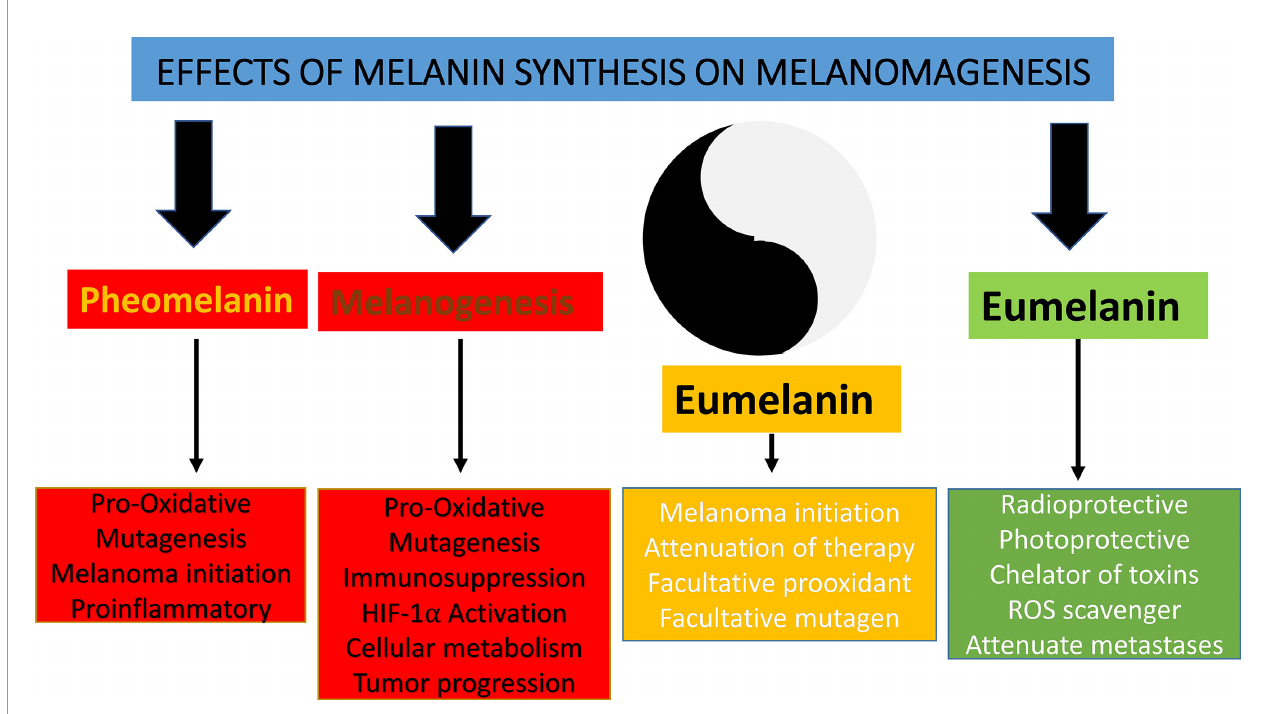
FIGURE 5 | Yin and Yang action of melanogenesis and melanin